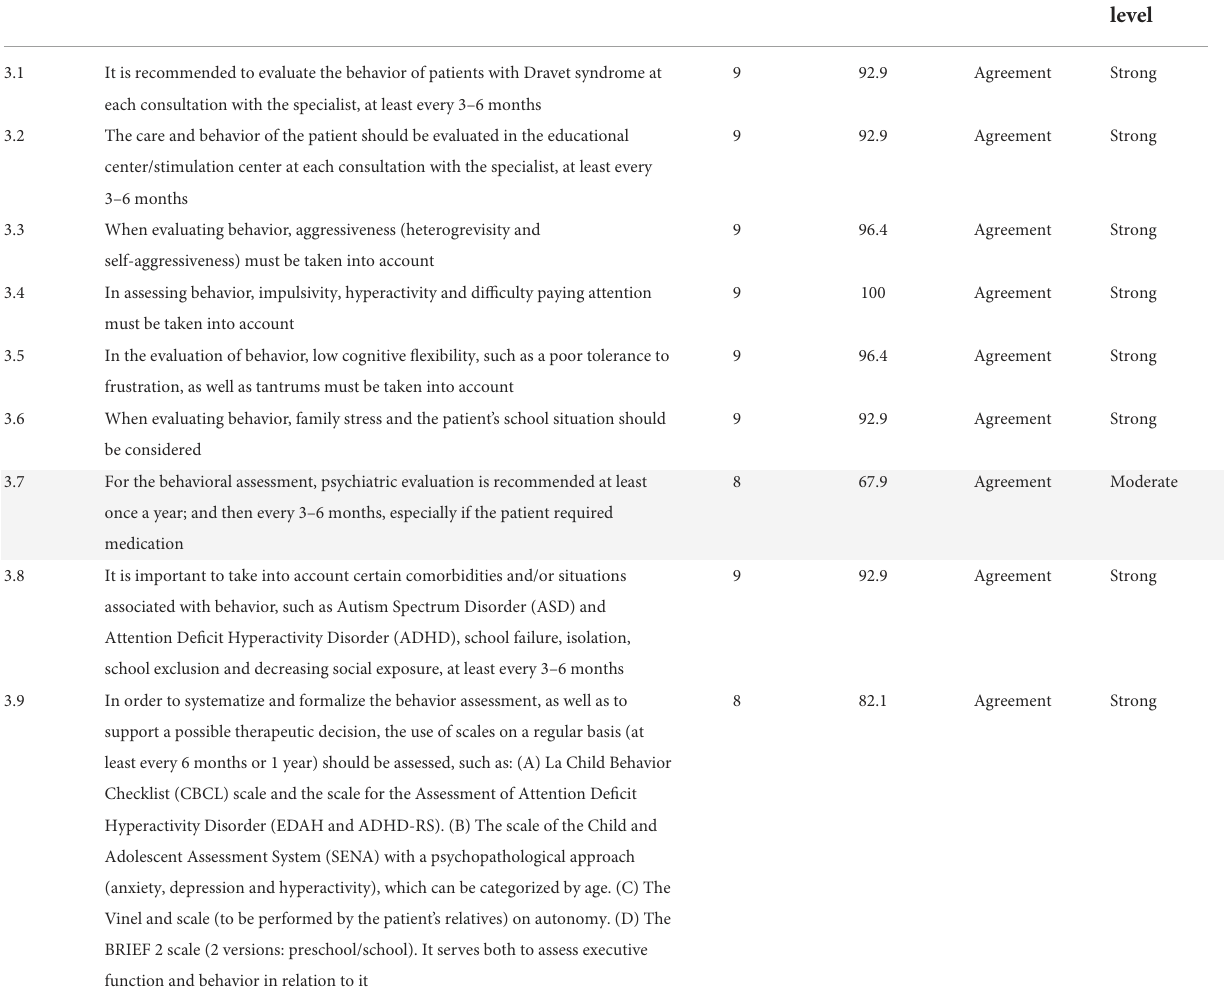
TABLE 3 Assessment of attention and behavior in patients with Dravet